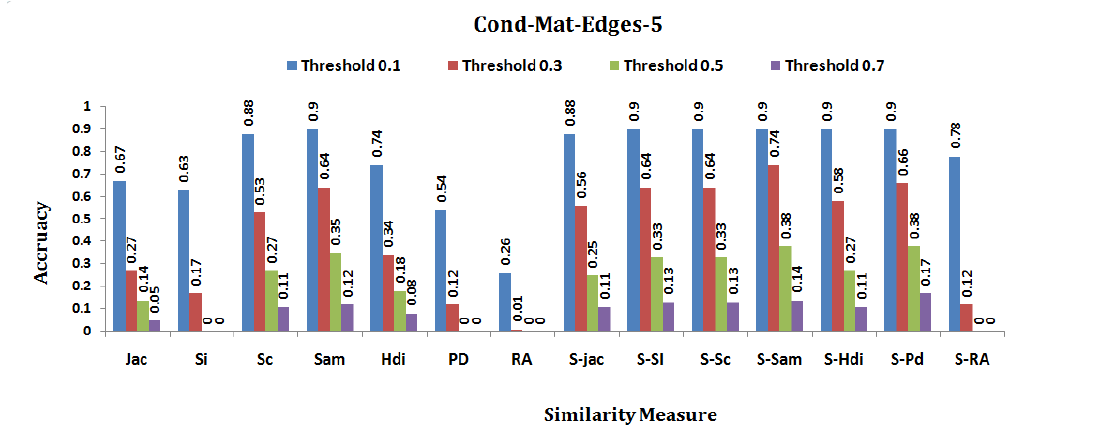
Figure 5. Prediction Results using CondMat Dataset with 5% Edges